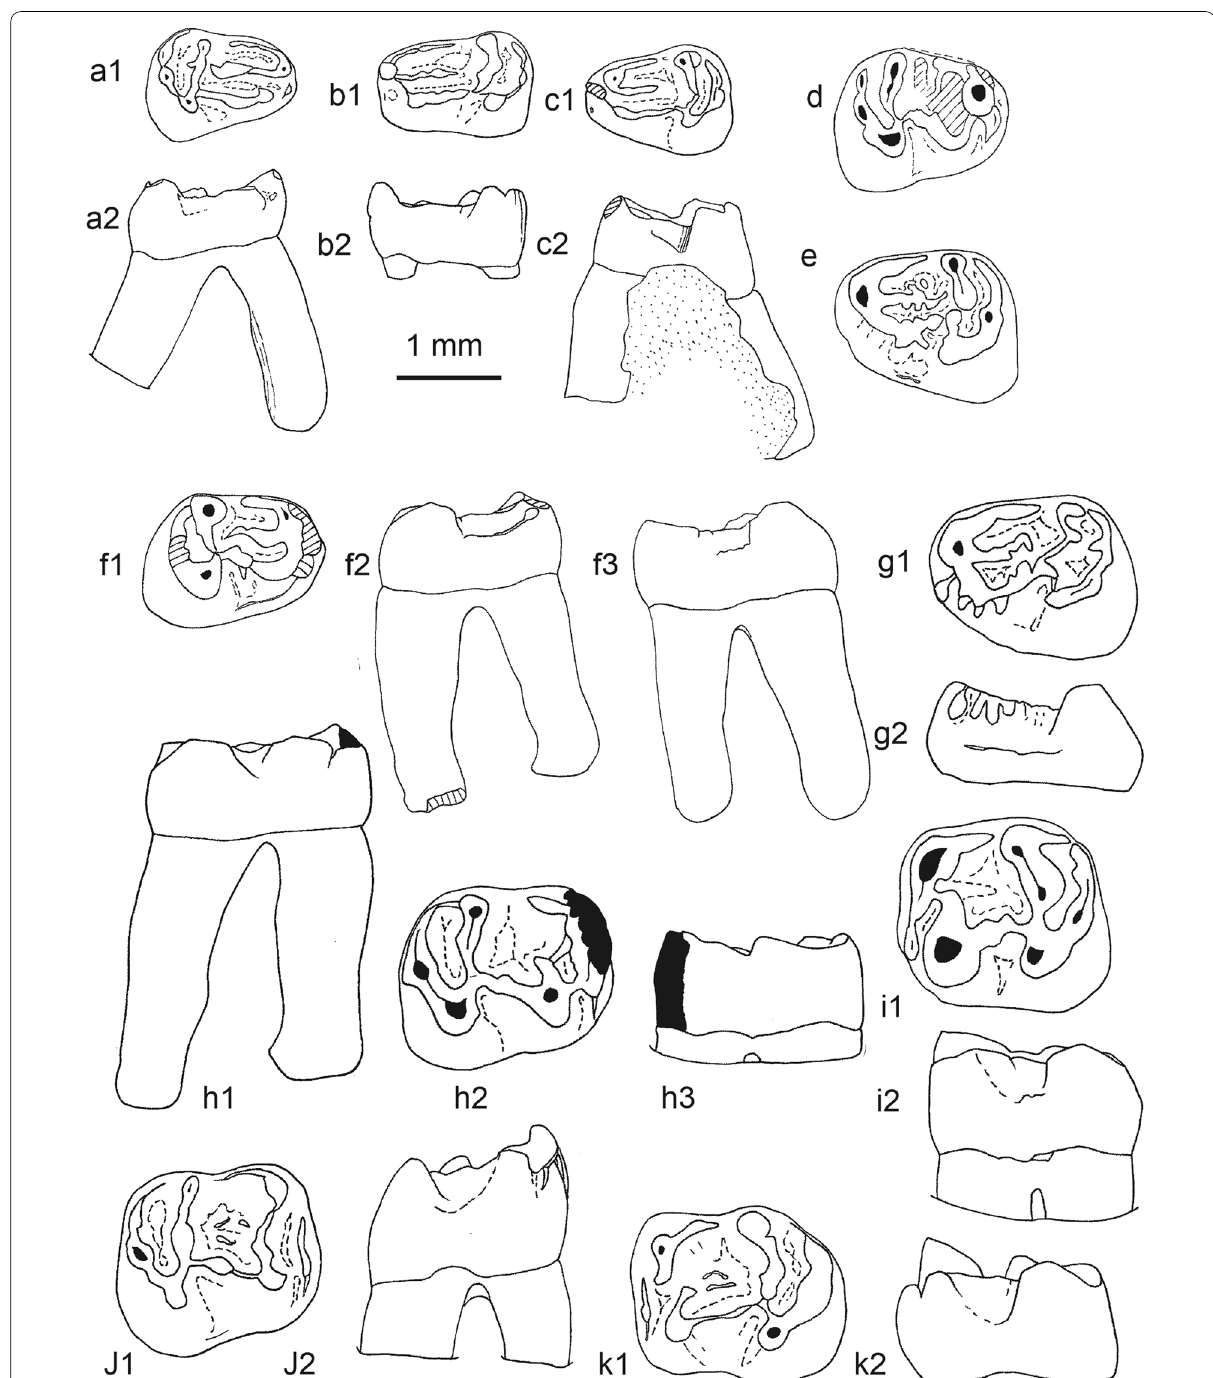
Fig. 25 Lower teeth of Protadelomys lugdunensis Hartenberger, 1969, from Laprade (Quercy), a LAP 207, right dp4; a1, occlusal view; a2, buccal aspect. b LAP 208, left dp4; b1, occlusal view; b2, lingual aspect. c : LAP 209, left dp4; c1, occlusal view; c2, lingual aspect. d LAP 210, right p4; occlusal view. e LAP 256, left p4, occlusal view. f LAP 212, right p4; f1, occlusal view; f2, buccal aspect; f3, lingual aspect. g LAP 251, left p4; g1, occlusal view; g2, buccal aspect. h LAP 254, right m1; h1, buccal aspect; h2, occlusal view; h3, lingual aspect. i LAP 217, left m1?; i1, occlusal view; i2, buccal aspect. j: LAP 218, right m1; j1, occlusal view; j2, buccal aspect. k : LAP 216, left m1; k1, occlusal view; k2, buccal aspect. Scale bar